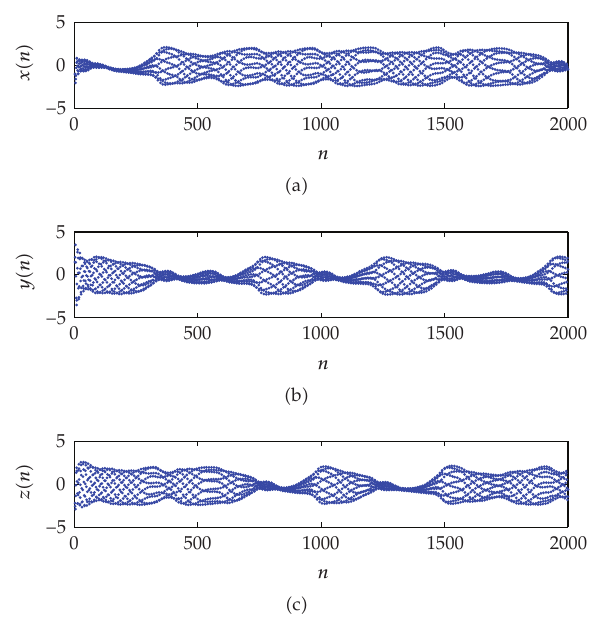
Figure 4: Time series for (cid:5) n,x n (cid:6) ; (cid:5) n,y n (cid:6) ; (cid:5) n,z n (cid:6) .